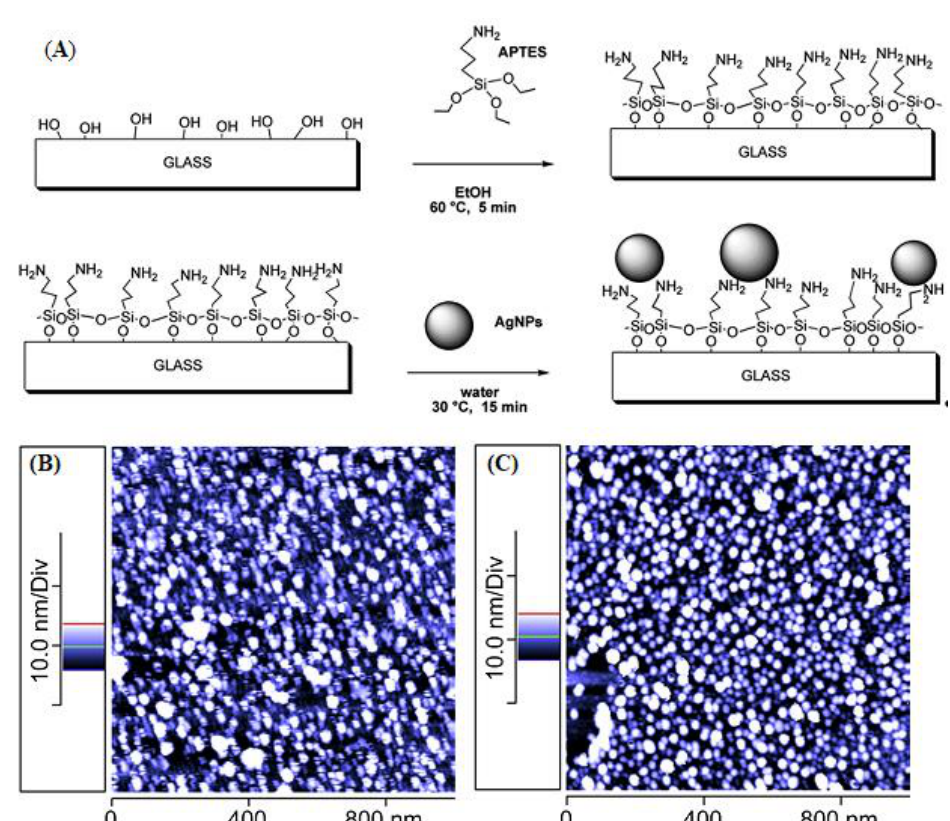
Figure 3. ( A ) Schematic diagram of making amine-functionalized glass substrate; ( B ) atomic force microscopy images (AFM) taken from a freshly prepared glass slide grafted with Ag NPs after silanization with aminopropyl silane (APTES) and ( C ) AFM image of the same glass slide kept